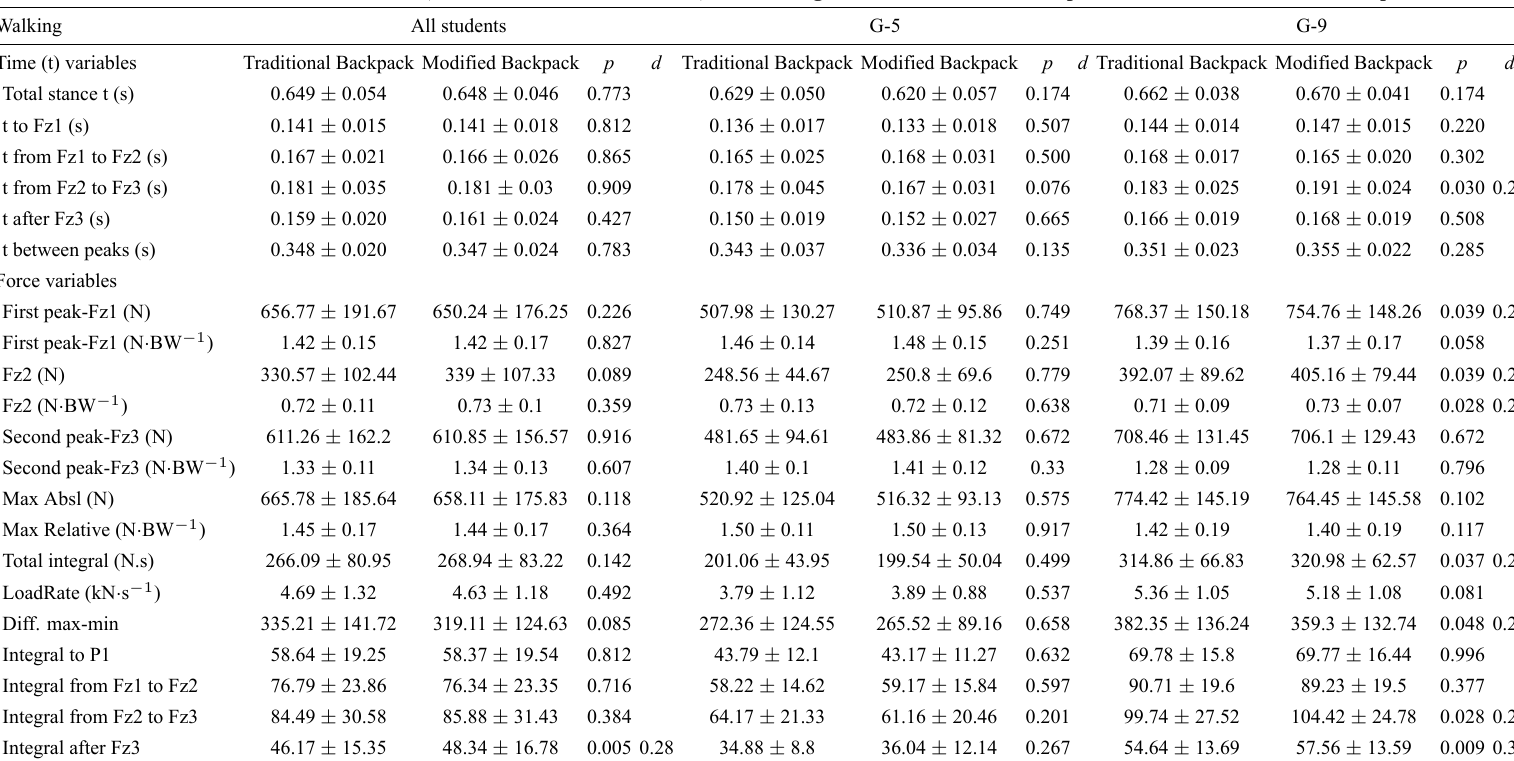
Table 1. Time and force variables (mean ± standard deviations) for walking with the traditional backpack and with the modified backpack. Walking All